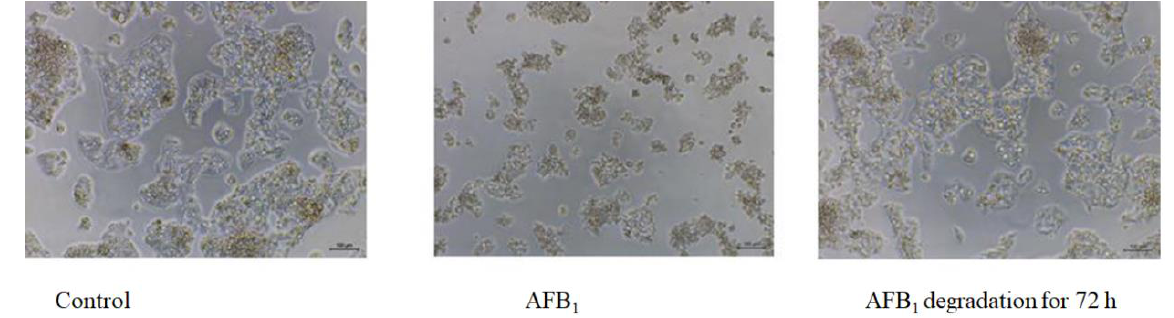
Figure 8. Effects of AFB 1 and its degradation products on HepG2 morphology.